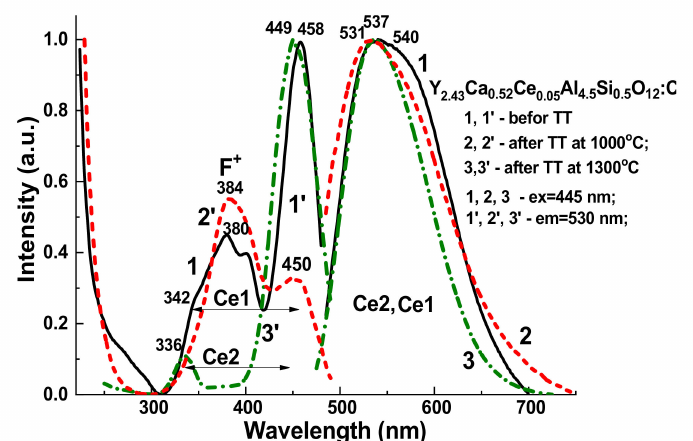
Figure 11. Influence of the thermal treatment in N 2 95% + H 2 5% atmosphere at 1000 ◦ C (2) and 1300 ◦ C (3) temperatures on the excitation spectra (1–3) and emission spectra (1 (cid:48) –3 (cid:48) ) of Ce 3+ lumines- cence in Y 2.43 Ca 0.52 Ce 0.05 Al 4.5 Si 0.5 O 12 SCF